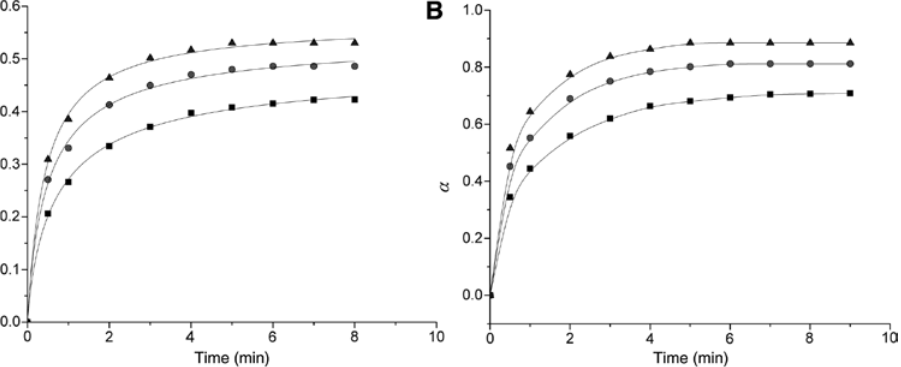
Figure 2: (A) The isothermal kinetic curves of the extracted caffeine from a guarana seed under microwave heating at 40 ° C ( ), 55 ° C ( ) and 60 ° C ( ). (B) Dependence of extraction degree ( α ) on time under microwave heating at 40 ° C ( ), 55 ° C ( ) and 60 ° C (